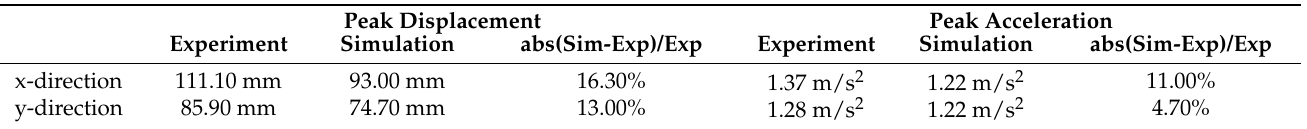
Table 9. Comparisons between experimental and simulated results of the b300d380 bearing under